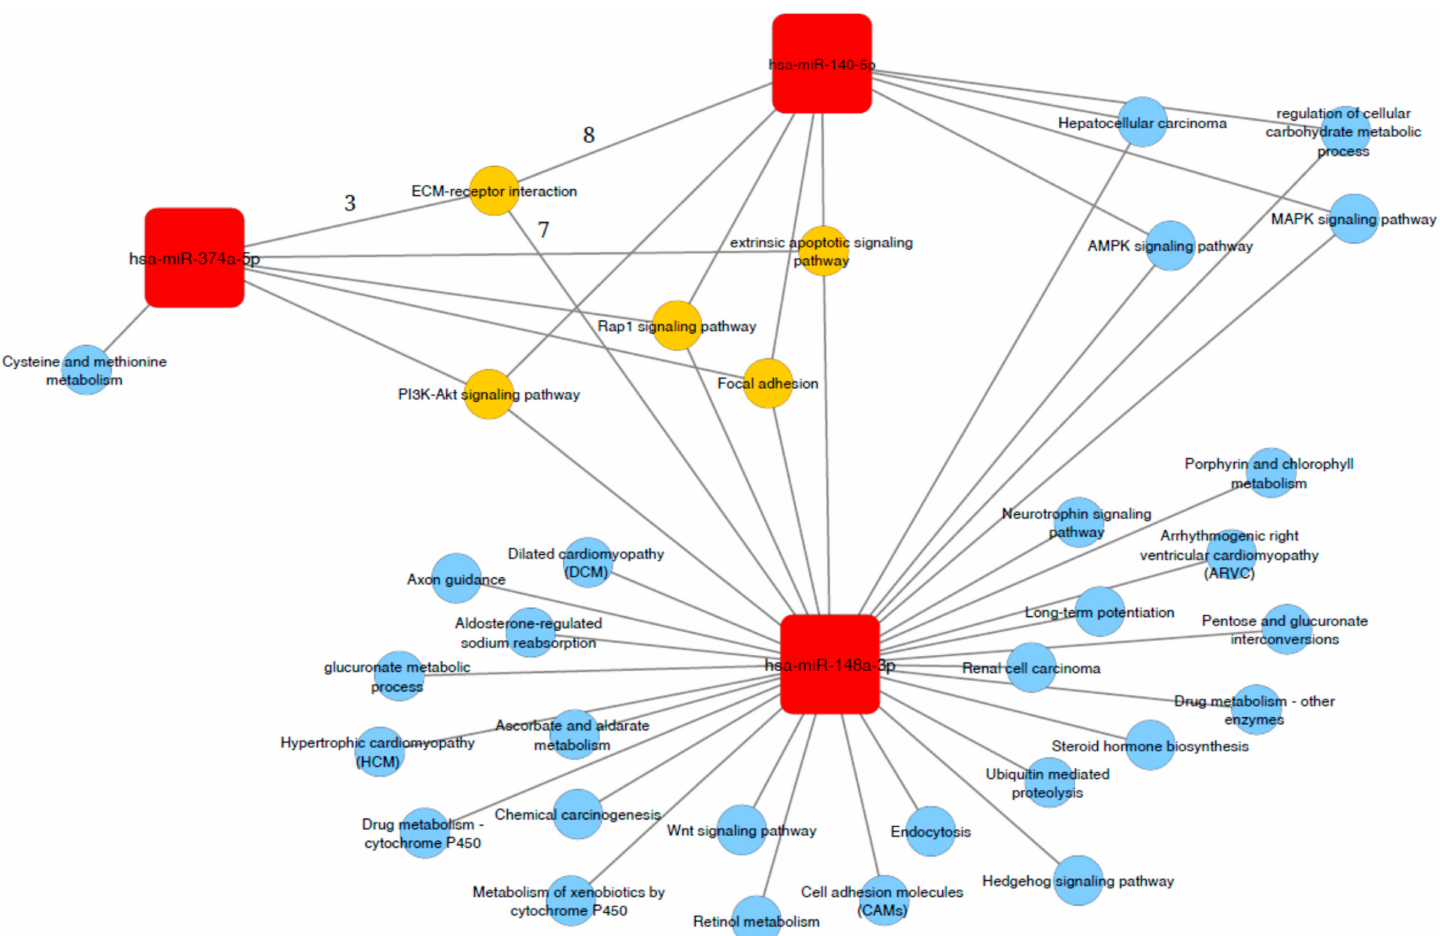
Figure 3. Functional interactions network analysis of ct-miR-148a-3p,ct-miR-140-5p, and ct-miR-374-a-5p. Specific (represented in blue) and common targeted signaling pathways (represented in yellow) of ct-microRNAs associated with pCR (i.e., miR 374a-5p, miR-148-3p and miR-140-5p, represented in red) obtained from GO and KEGG database analyses. The number of ct-miR-148a-3p,ct-miR-140-5p, and ct-miR-374-a-5p target genes related to ECM pathway are represented above the